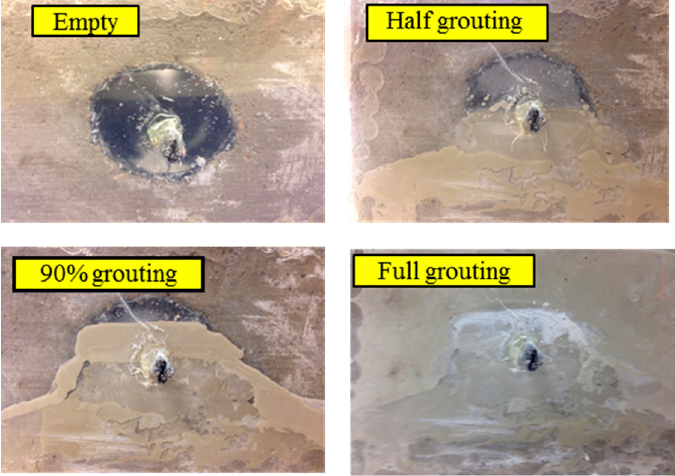
Figure 9. Specimen in four different grout stages.